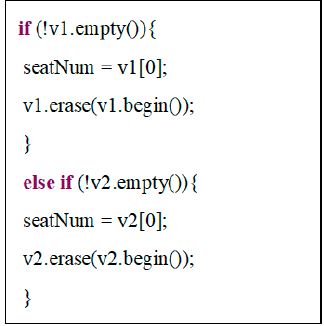
Figure 9. Back-to-Front random seats selection.